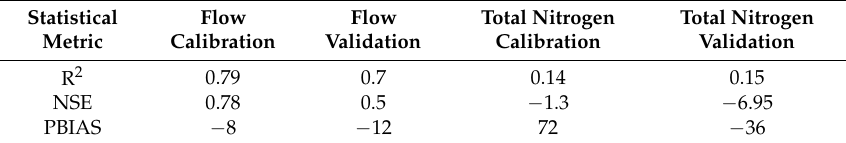
Table 6. With OWTS input.